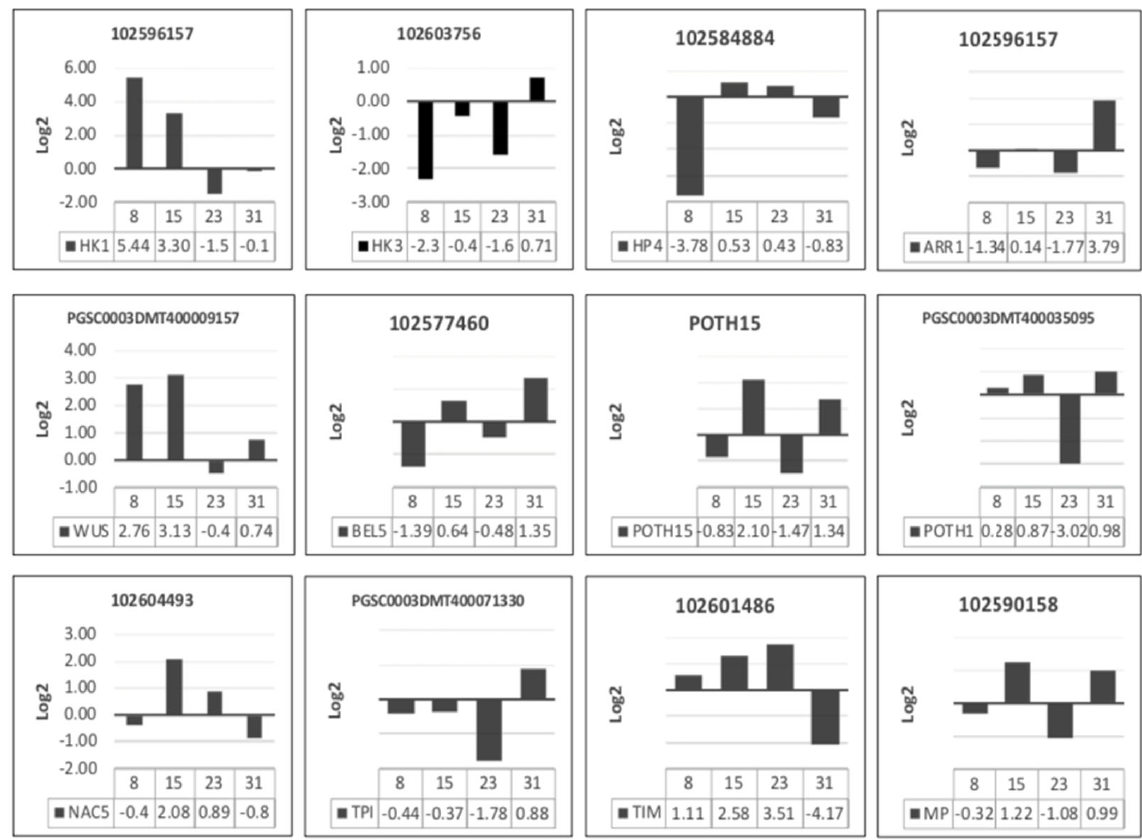
Figure 3. Gene expression analysis by qPCR during microtuber induction in osmotic stress medium (MR8 ‐ G6 ‐ 2iP) after 8, 15, 23 and 31 days of incubation in darkness. Control medium was non ‐ osmotic medium (MR1 ‐ G3 ‐ 2iP). Relative expression levels plotted based on Log2. Normalized with EF1 ɑ (elongation factor 1 ɑ ) and SEC3 (exocyst complex component 3). Table 1. Primer design of genes that were analyzed during microtuber induction of potato S. tuberosum cv. Alpha.